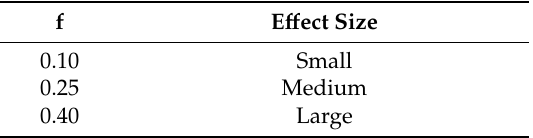
Table 2. E ff ect sizes of Cohen’s f according to ([52], pp.